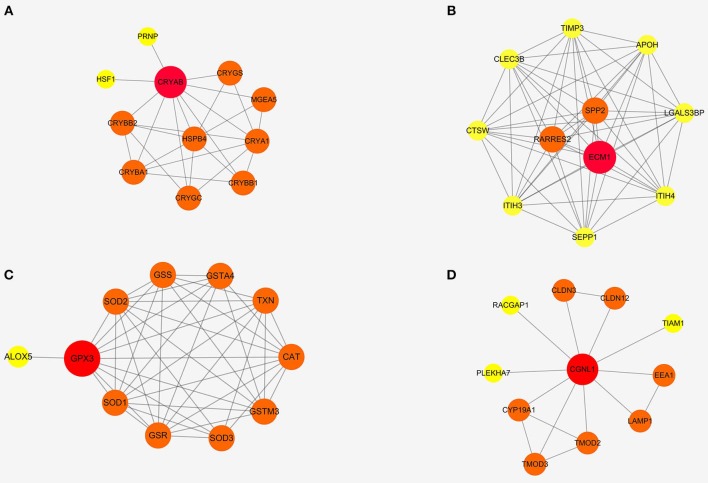
Protein-protein interaction (PPI) networks of four modules based on ECM1, GPX3, CRYAB, and CGNL1. (A) CRYAB module PPI network; (B) ECM1 module PPI network; (C) GPX3 module PPI network; and (D) CGNL1 module PPI network.